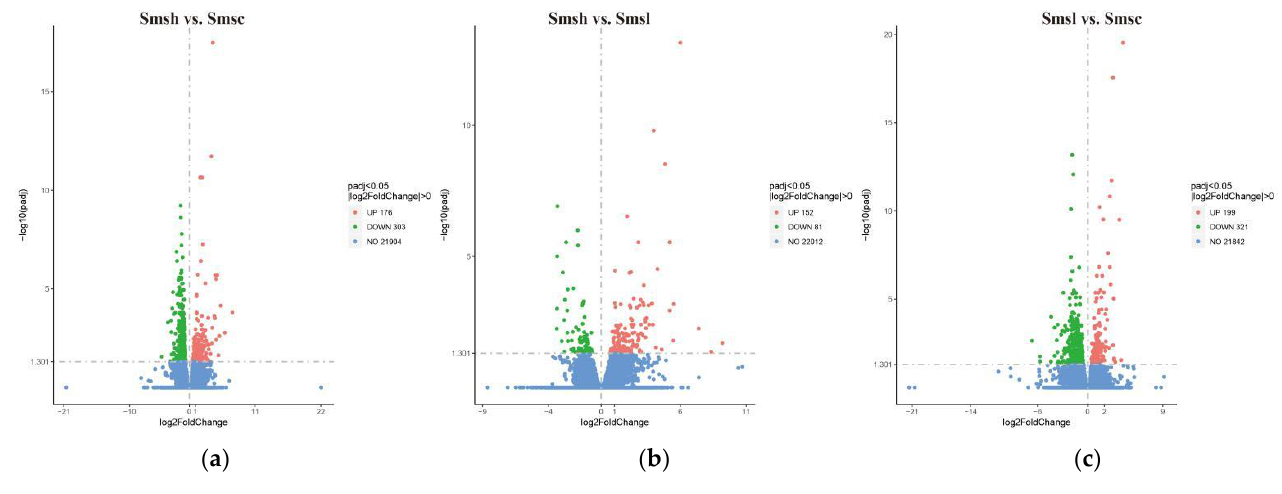
6 of 17 Figure 1. Expression level analysis diagram. (a) Gene expression box diagram. (b) Sample correla- tion heatmap of gene expression. The differential genes in the high- salt group (35‰), control group (20‰), and low -